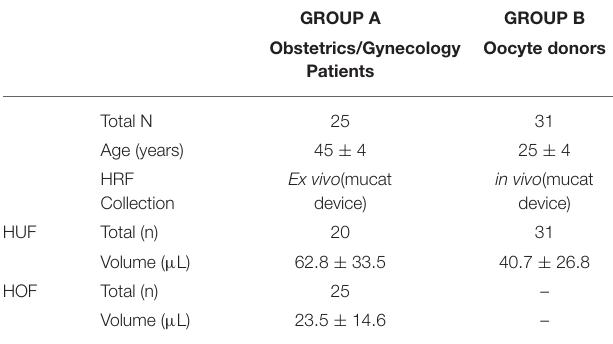
TABLE 1 | Demographic characteristics of the study population and collected volume (mean ± SD) of reproductive fluids (RFs) for physicochemical and functional